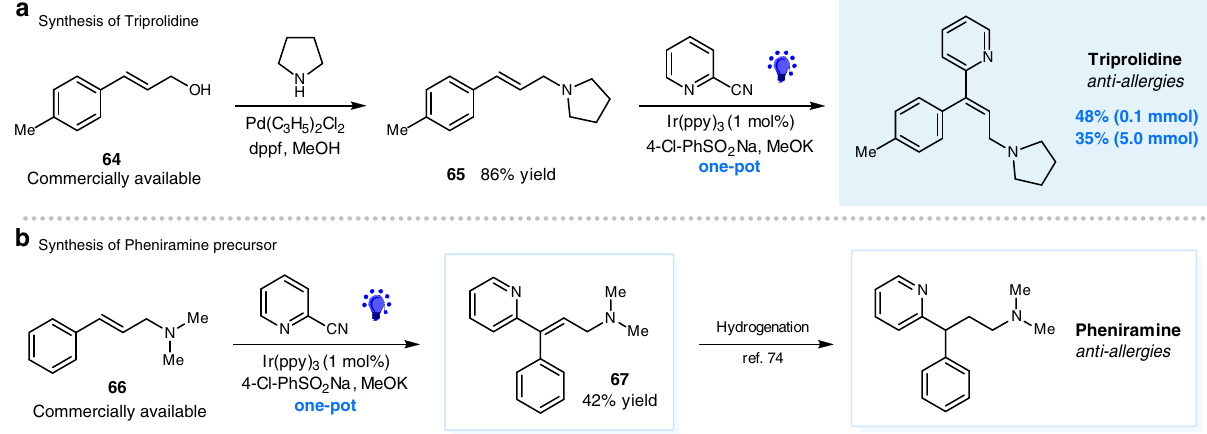
Fig. 5 Synthesis of Triprolidine. a One-pot synthesis of Triprolidine via photoredox catalysis. b Synthesis of pheniramine